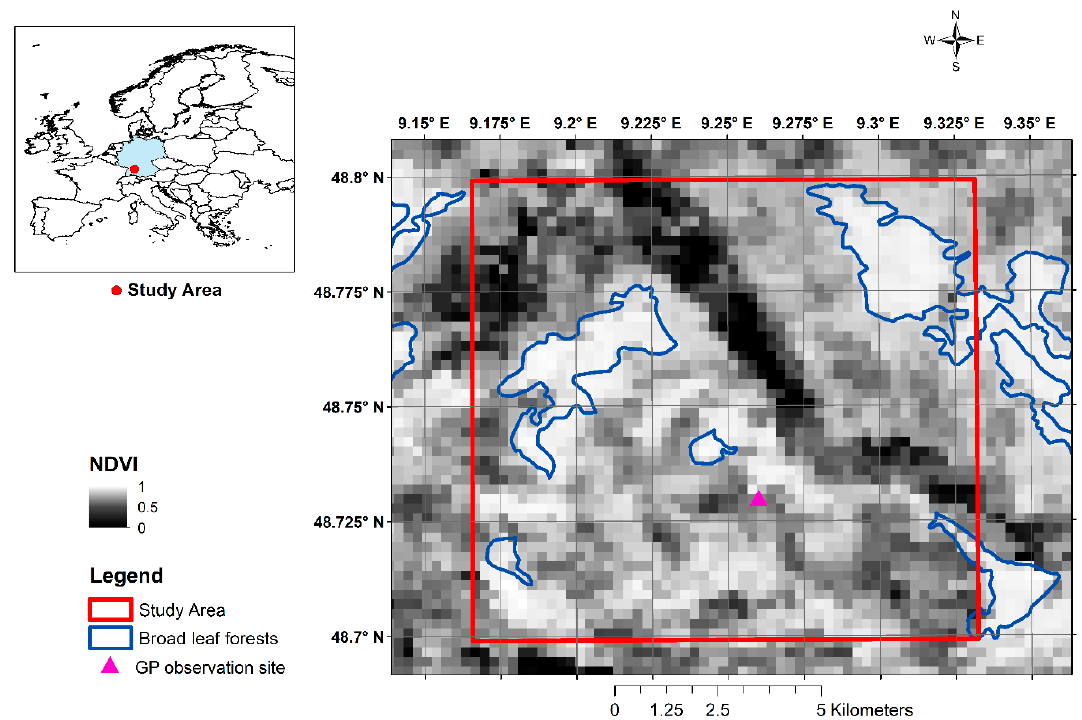
Figure 1. Study area and CORINE land cover map showing the distribution of broadleaf forests. (NDVI image is for day of the year (DOY) 145 in 2001). Inset: Location of study area in Germany.